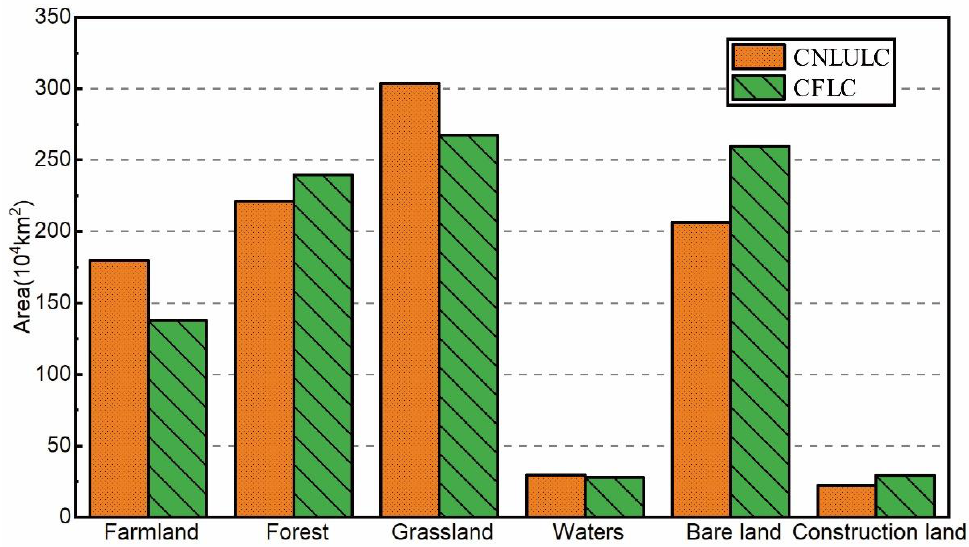
Figure 4. Comparison of total area of 6 classes between the CFLC and CNLULC.